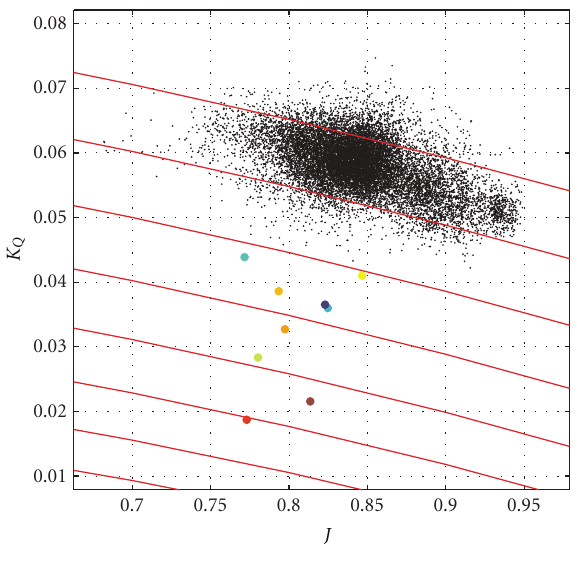
Figure 6: Flagged